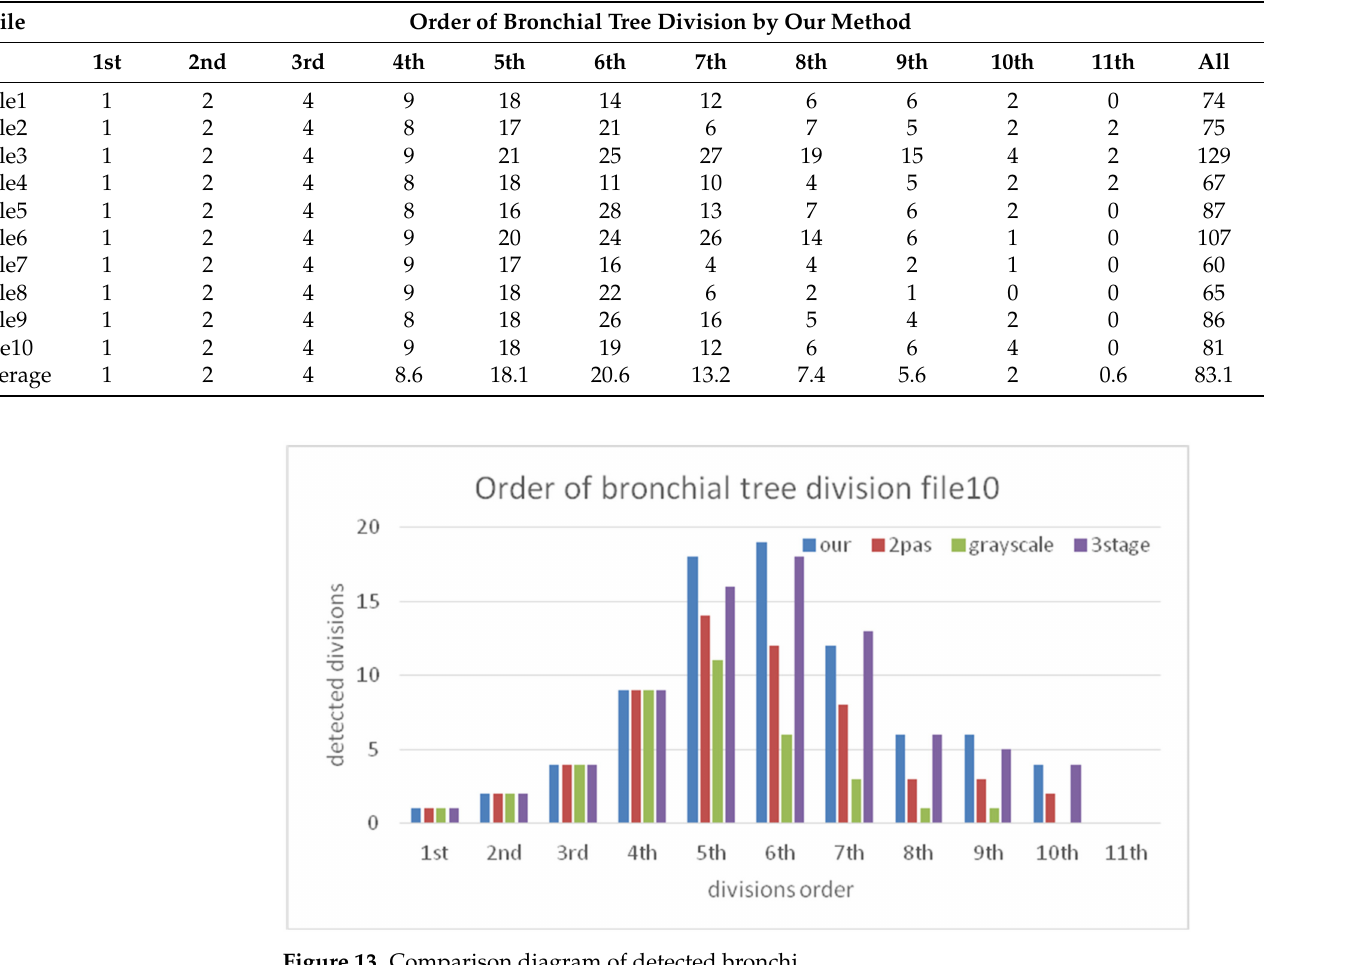
Figure 13. Comparison diagram of detected